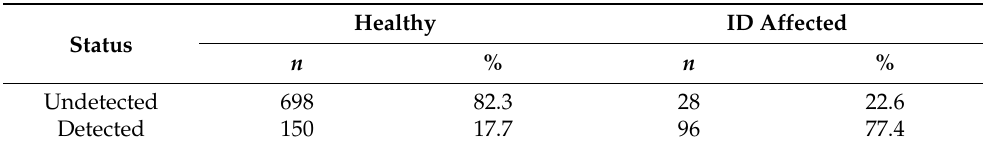
Table 6. Frequency distribution of Dichelobacter nodosus detection by clinical status for 972 foot-level observations.